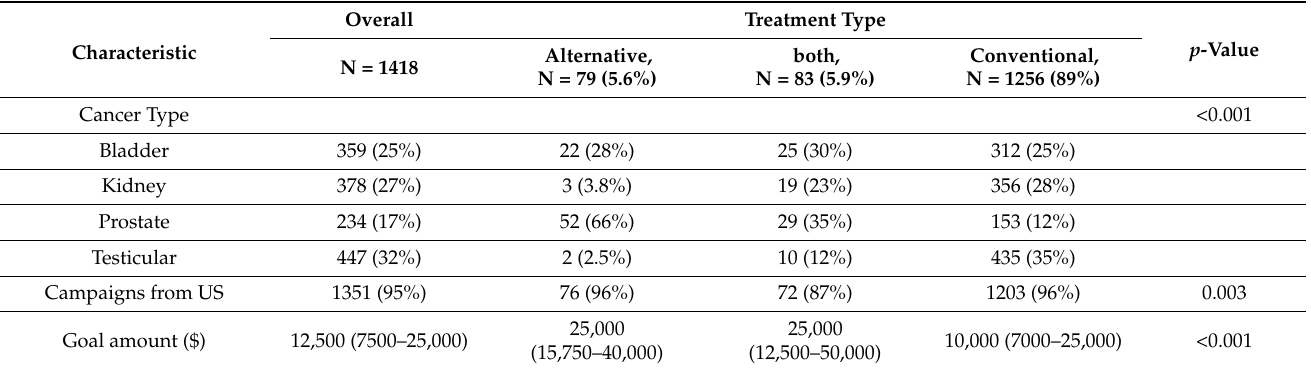
Table 2. Characteristics of 1418 GoFundMe.com online crowdfunding campaigns fundraising for urologic malignancies stratified by treatment